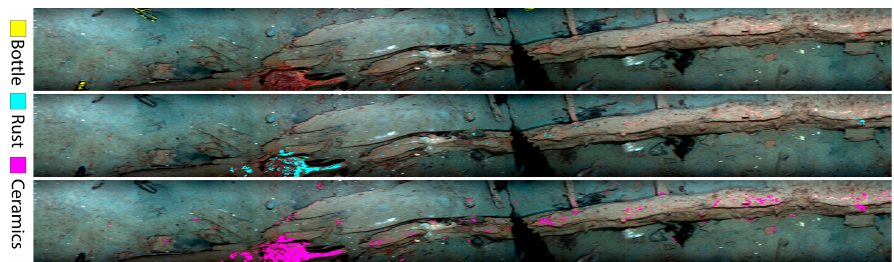
Figure 6. Supervised SAM classification images of a wreck transect. From top to bottom: Glass bottle, rust, and ceramics. Picture is rotated 90° clockwise. Reprinted with permission from Ødegård et al. [27]. © The Optical Society.